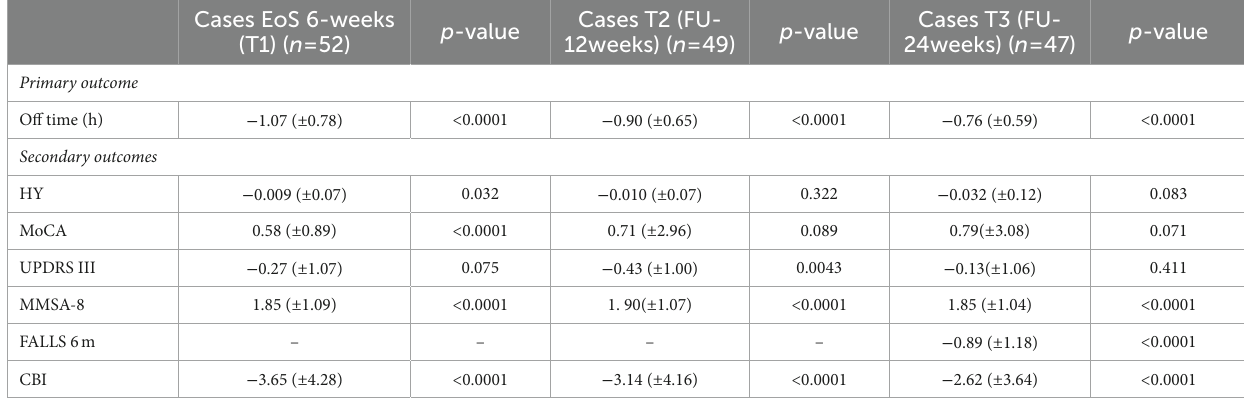
TABLE 5 Six-weeks (T1), 12-weeks (T2) and 24-weeks (T3) follow-up outcome measures for all participants and comparison with baseline (T0) within the intervention group.